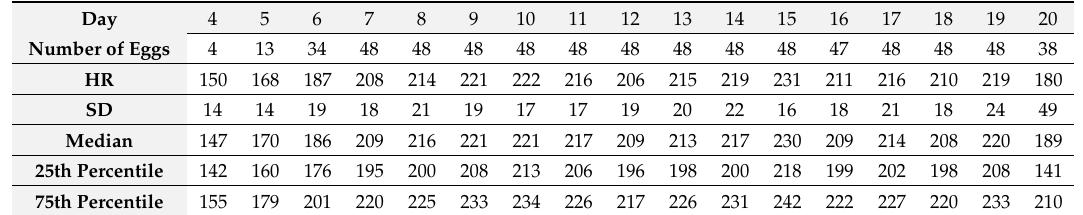
Table 1. Mean chicken embryonic HR, standard deviation, median and interquartile range of fertile and live eggs, throughout the incubation measured using the proposed smartphone device setup and the custom Android application. All parameters are given in